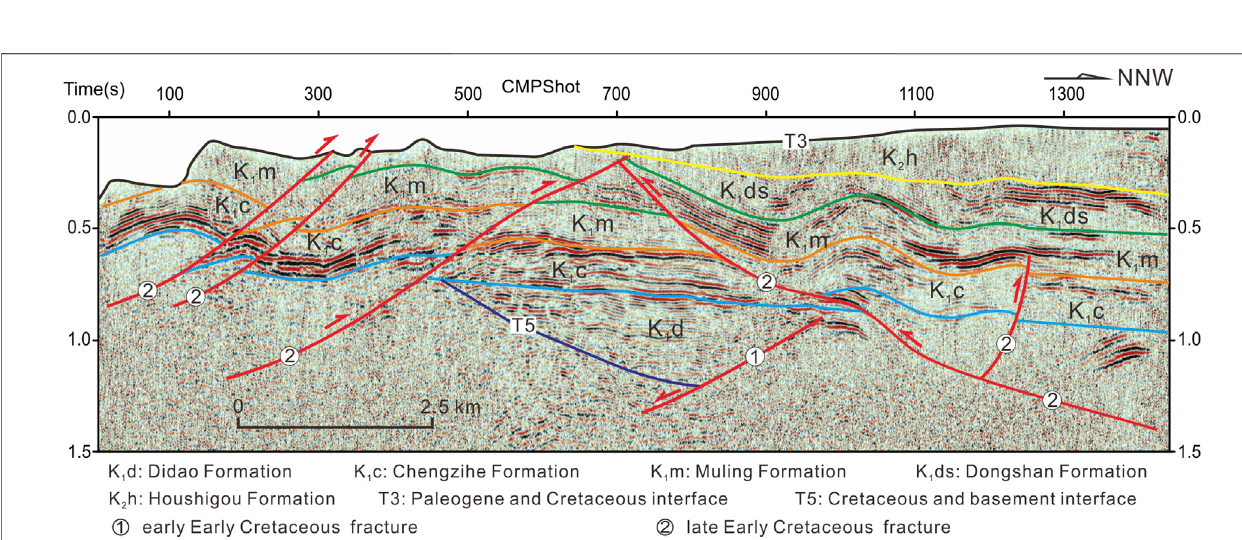
Frontiers in Earth Science |